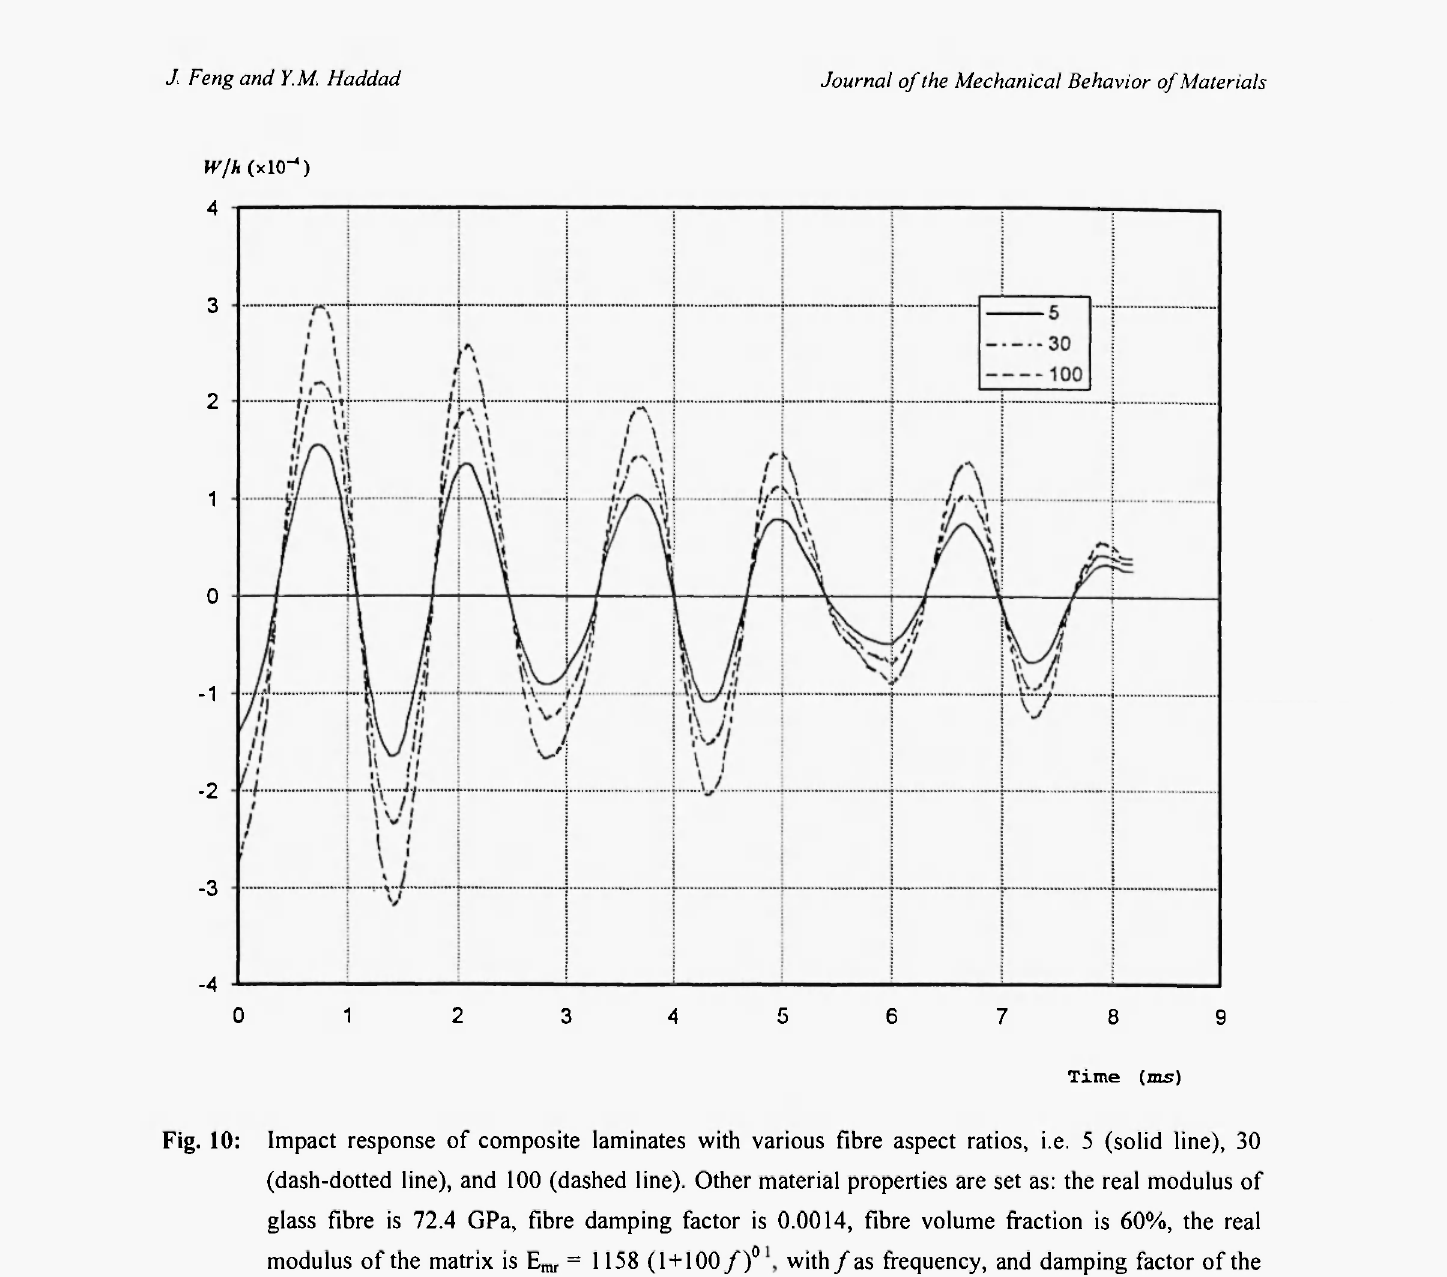
Fig. 10: Impact response of composite laminates with various fibre aspect ratios, i.e. 5 (solid line), 30 (dash-dotted line), and 100 (dashed line). Other material properties are set as: the real modulus of glass fibre is 72.4 GPa, fibre damping factor is 0.0014, fibre volume fraction is 60%, the real modulus of the matrix is E m = 1158 (1 + 1 0 0 / ) ° w i t h / as frequency, and damping factor of the matrix is